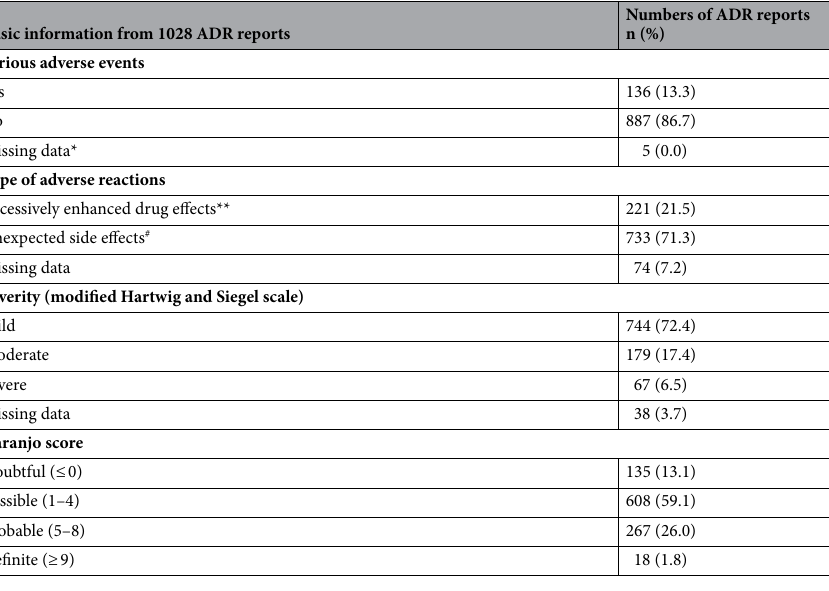
Table 3. Basic information from 1028 ADR reports in the TADRRS-HM (1998–2016). TADRRS-HM Taiwan Adverse Drug Reaction Reporting System for Herbal Medicine. *Missing data refer to ADR records that were incompletely filled. **Excessively enhanced drug effects refer to those that occur in patients prescribed a normal therapeutic dosage who experience amplified side effects from the medicine due to their individual characteristics. For example, during normal use/dosage, licorice can result in abdominal fullness, but some patients may experience excessive abdominal fullness. # Unexpected side effects are those that are previously unknown in relation to a particular